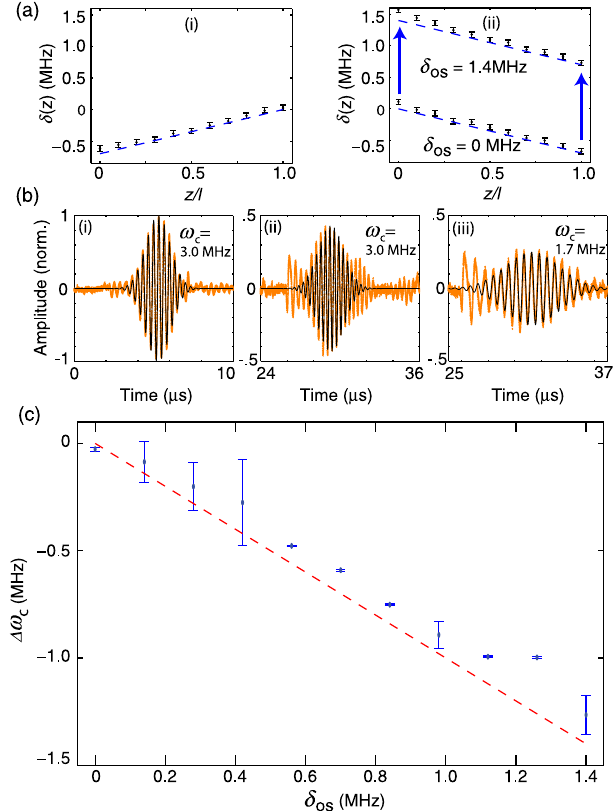
FIG. 3. Manipulating pulse frequency. (a) Two-photon detun- ing (cid:5) as a function of position z along the memory (normalized to length l ) due to (i) the input gradient and (ii) output gradients, with minimum and maximum gradient offset (cid:5) os (as noted on figure). The blue (dashed) line corresponds to the desired field, and points correspond to the measured magnetic field. (Error bars are due to the sensitivity of the Gauss meter.) (b) Heterodyne data showing (i) input pulse, (ii) echo for recall with (cid:5) os ¼ 0 , and (iii) echo for recall with (cid:5) os ¼ 1400 kHz offset. Orange points correspond to raw data, black lines corre- values corre- spond to modulated Gaussian fit to data, and ! c spond to the center frequencies of pulses extracted from the fits. (c) The change in the center frequency of the output pulses relative to the input pulse (cid:2) ! c as a function of (cid:5) os . Points represent the measured center frequency (error bars are from standard deviation of 100 traces), and the dashed line corre- sponds to the theoretical